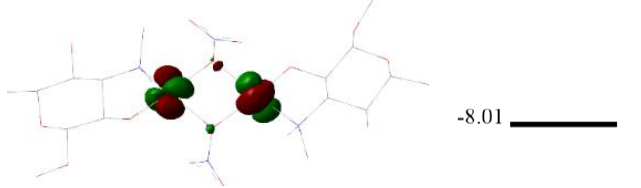
Figure 9. Energy (in eV) and plot of SOMO_1 ( left ) and SOMO_2 ( right ) of the dinuclear copper(II) blue mycaminosate complex 4 ( BHandHLYP ).